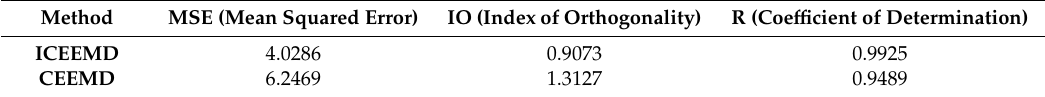
Table 1. The comparison of ICEEMD and